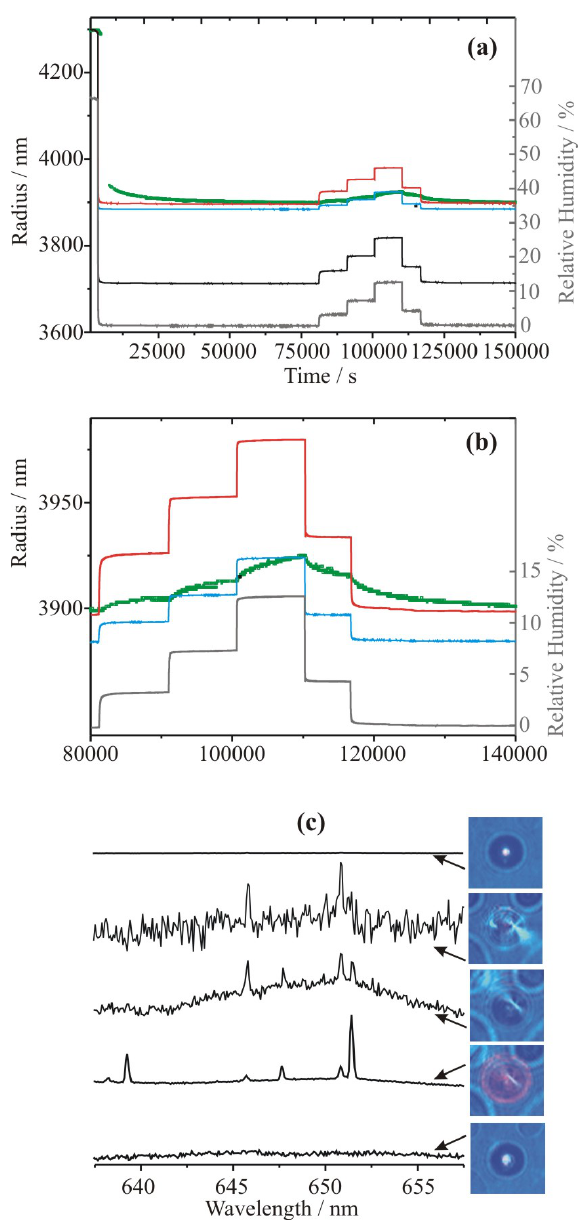
Fig. 4. (a) Time-dependence of the size of a sucrose droplet (green) with change in RH (grey line, right axis). The sizes predicted at equilibrium using the Norrish (red line), Zobrist (light blue line) and ADDEM (black line) thermodynamic models are shown for com- parison. The rapidly changing size cannot always be determined from measurements at early time following the sudden decrease in RH due to the rapid translation in WGM wavelengths. This gives rise to the broken time-record of measured size at times of ∼ 10000s. (b) Same as for (a) but showing expanded view around 100000s. (c) Final images and Raman spectra of the glassy sucrose particle when deposited on the coverslip and with varying image height. From top to bottom: laser focus below the coverslip, at the bottom surface of the particle, at the middle of the particle, at the top surface of the particle and above the